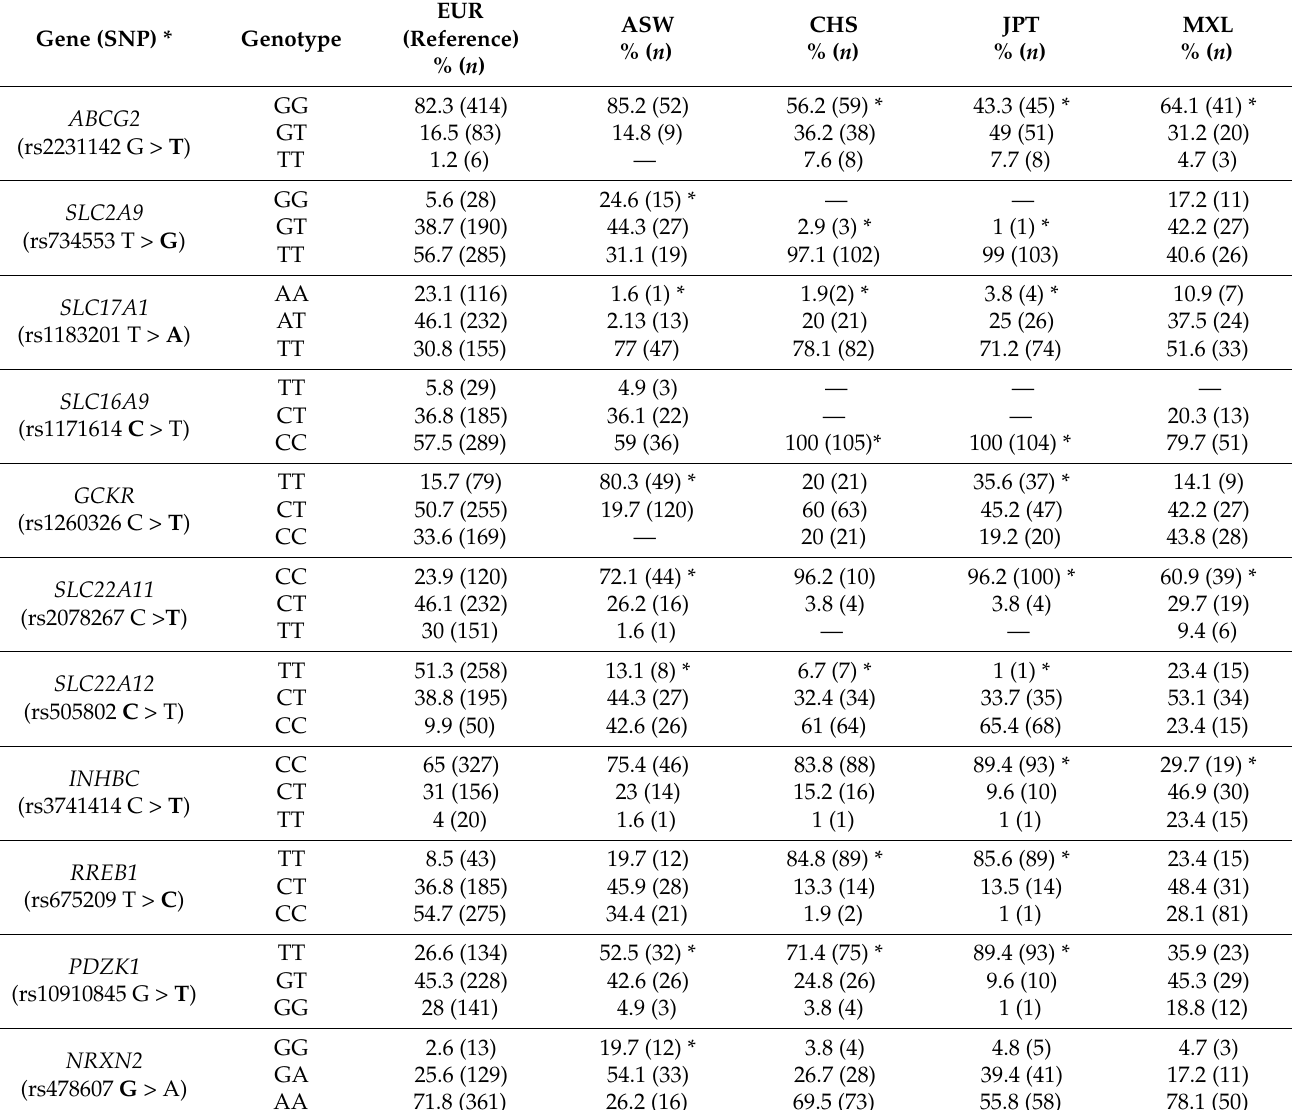
Table 3. Genotype frequencies comparisons across populations.